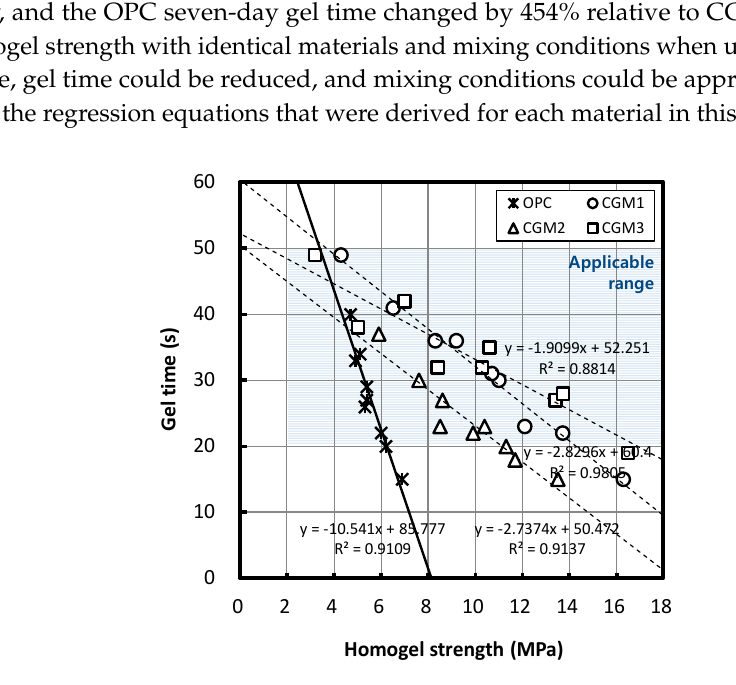
Figure 10. Correlations between homogel strength and gel time.